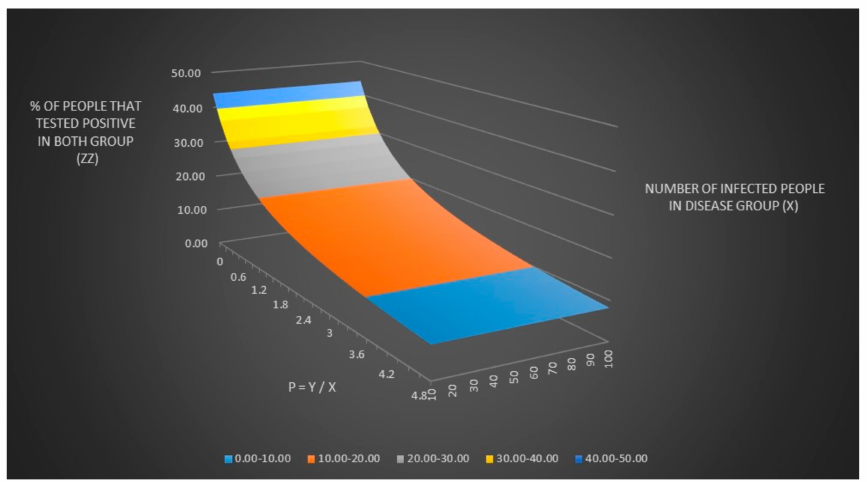
Figure 5. The % number of people that tested positive in both groups (zz) adjusted for the relationship between y and x (p).